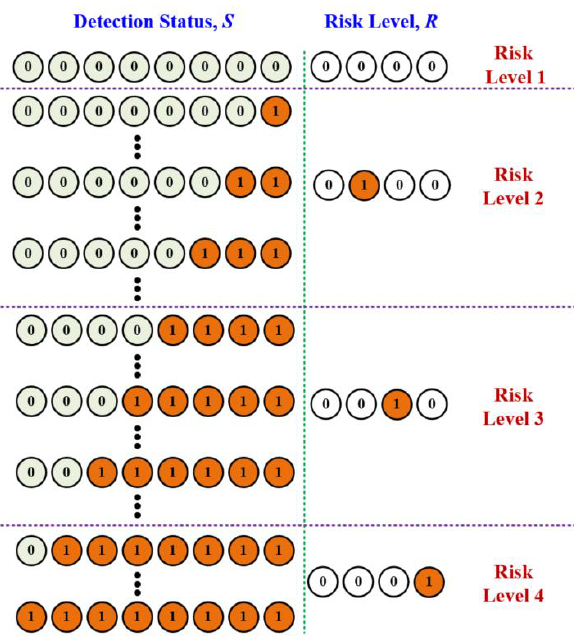
Figure 5. Correspondence between different combinations of binary patterns and risk levels.